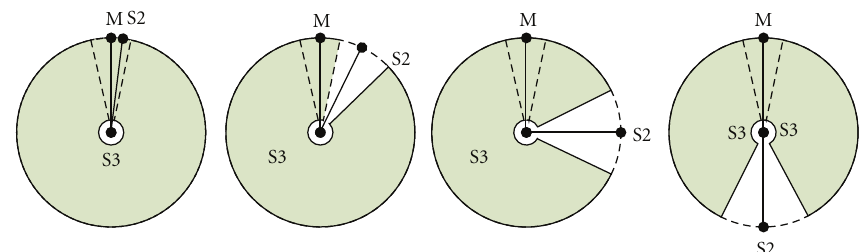
Figure 17: Appropriate constellations of three satellites for the usage of a Master-Slave approach (M—Master, S2, S3—Slaves, with φ M = φ = φ 2 3 ). The coloured fields indicate appropriate positions of S3. The inappropriate positions for S3 are